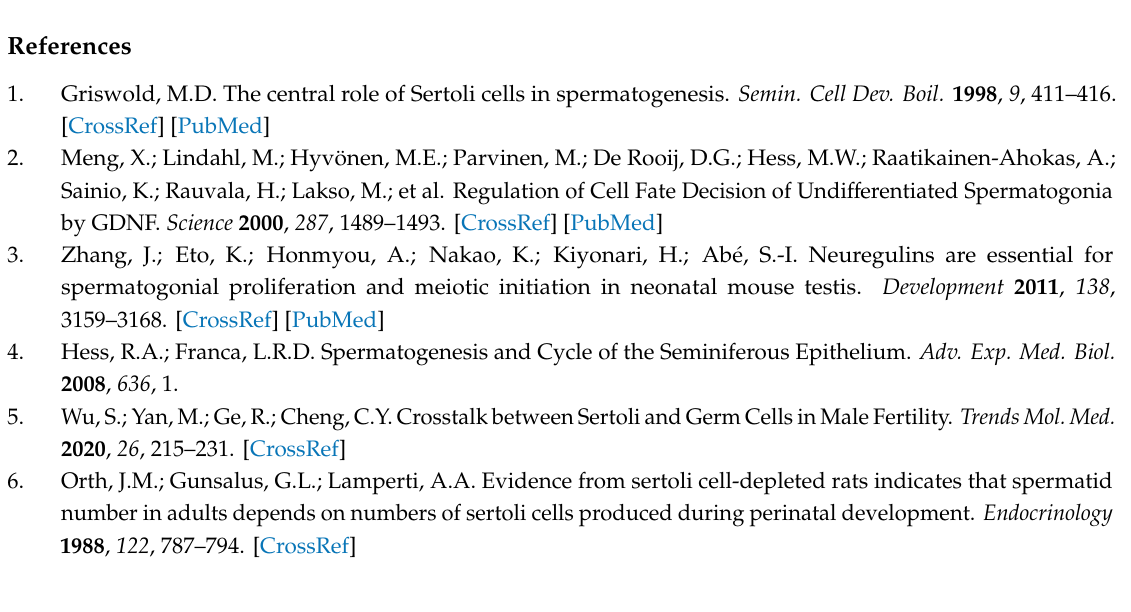
Figure S1: Functional assessment of the BTB in control and E4f1 cKO mice testis, Figure S2: Rb1 , p21 , and Dlat expression level in PD0 control and E4f1 cKO testes, and γ H2AX and SOX9, GATA4 and P53 protein expression in Sertoli cell from PD0 control and E4f1 cKO testes. Table S1: Information of antibodies used in the